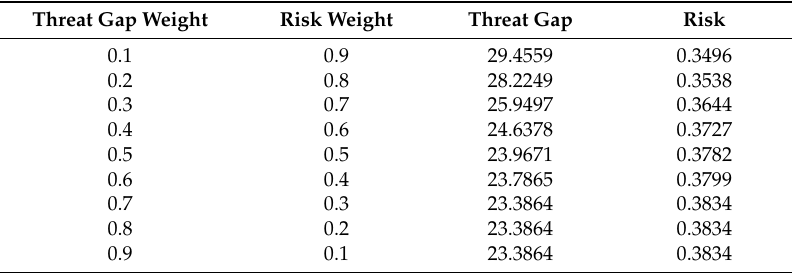
Table 11. Comparison of algorithm